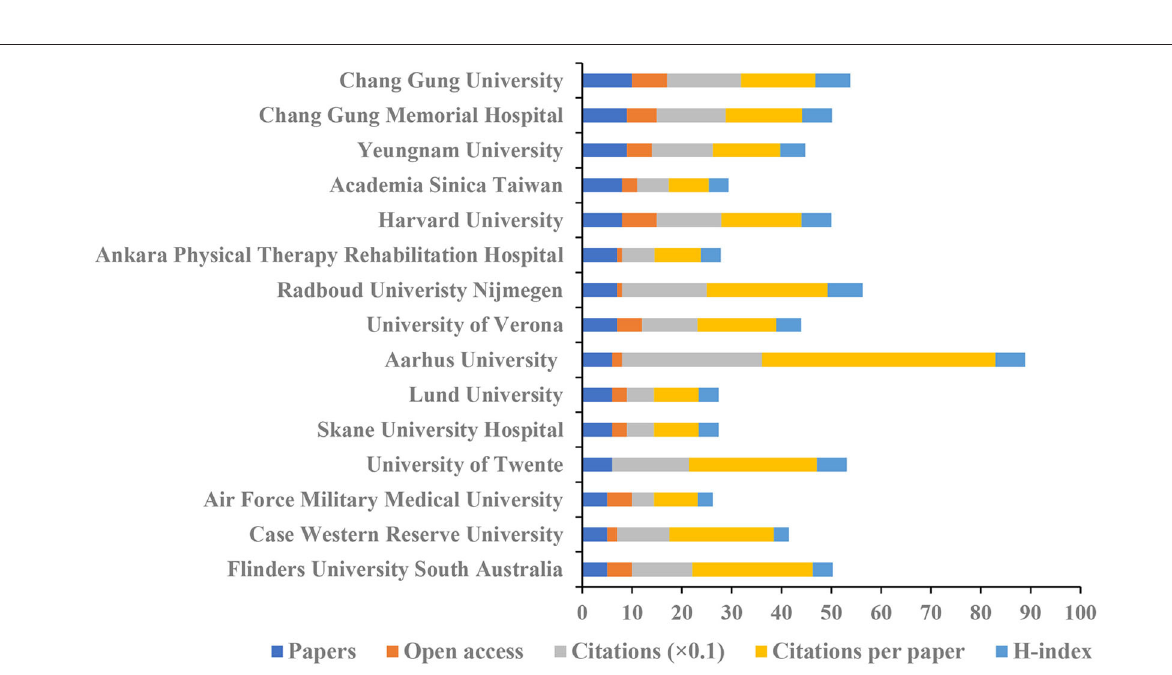
Frontiers in Molecular Neuroscience |